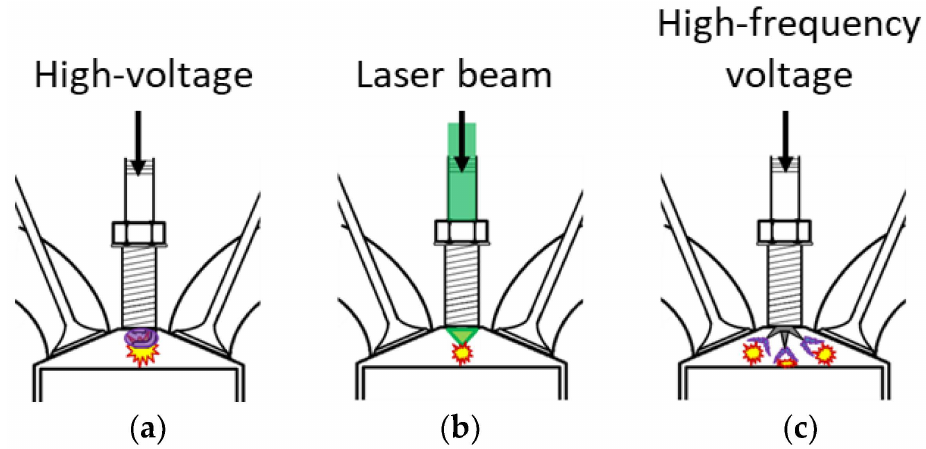
Figure 5. Schematics of the combustion engines ignited by: ( a ) a spark plug, ( b ) a laser, and ( c ) shows multi-point